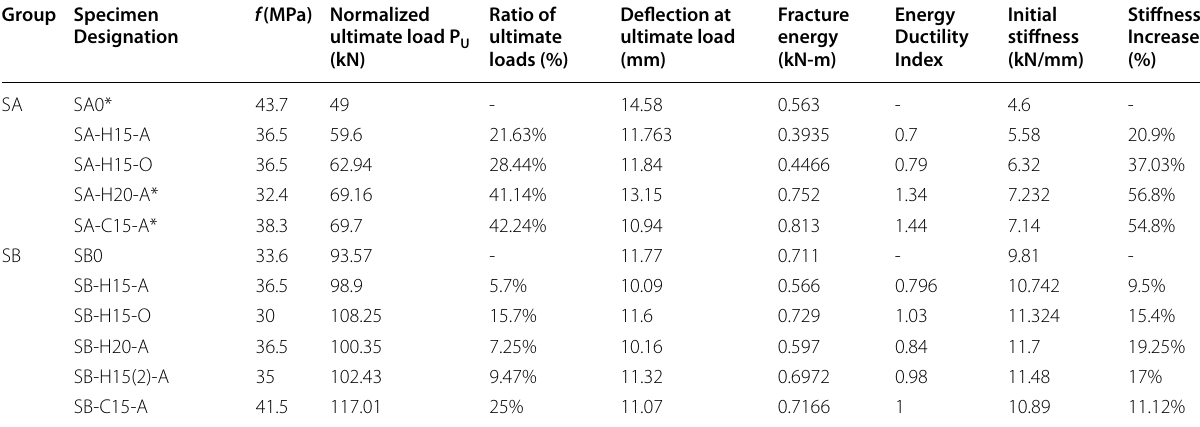
Table 4 Summary of the test results.